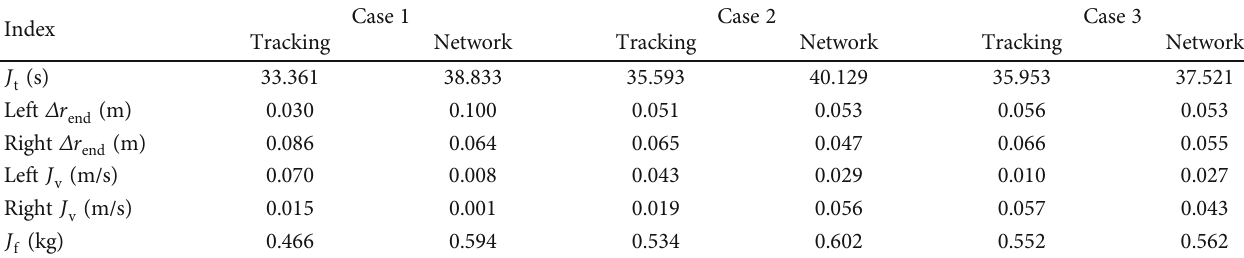
Table 6: Simulation results for the fi rst three veri fi cation cases.